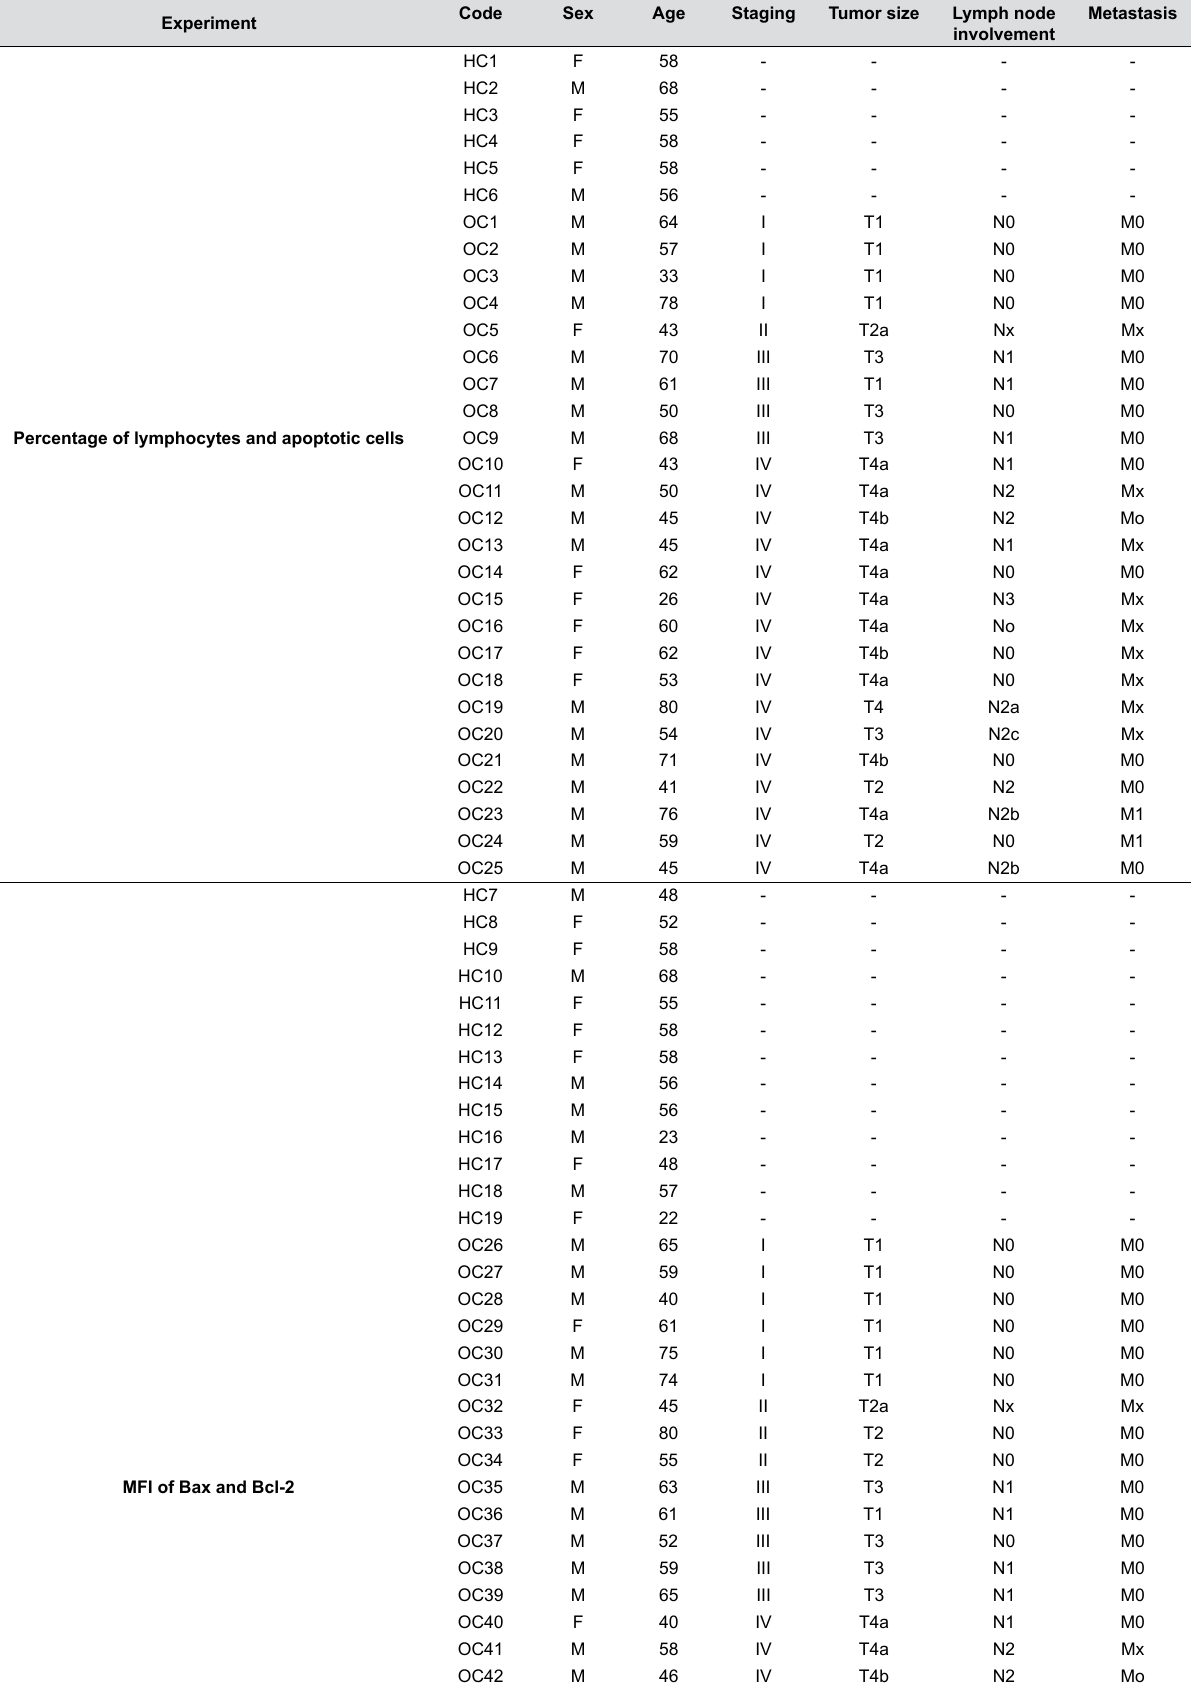
Table 1- Detailed data of samples in cohorts 1 and